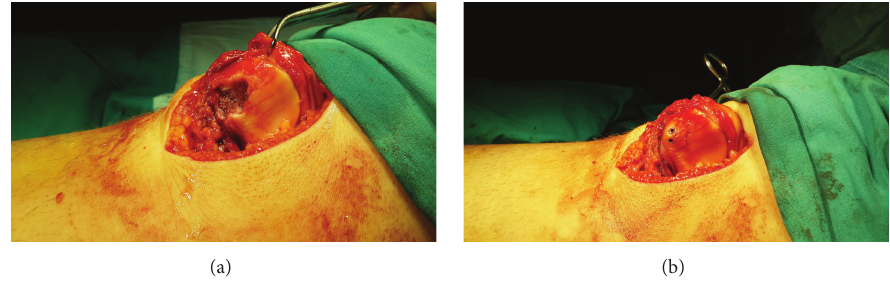
Figure 2: Osteochondral defect area after debridement (a), osteosynthesis with two headless compression screws